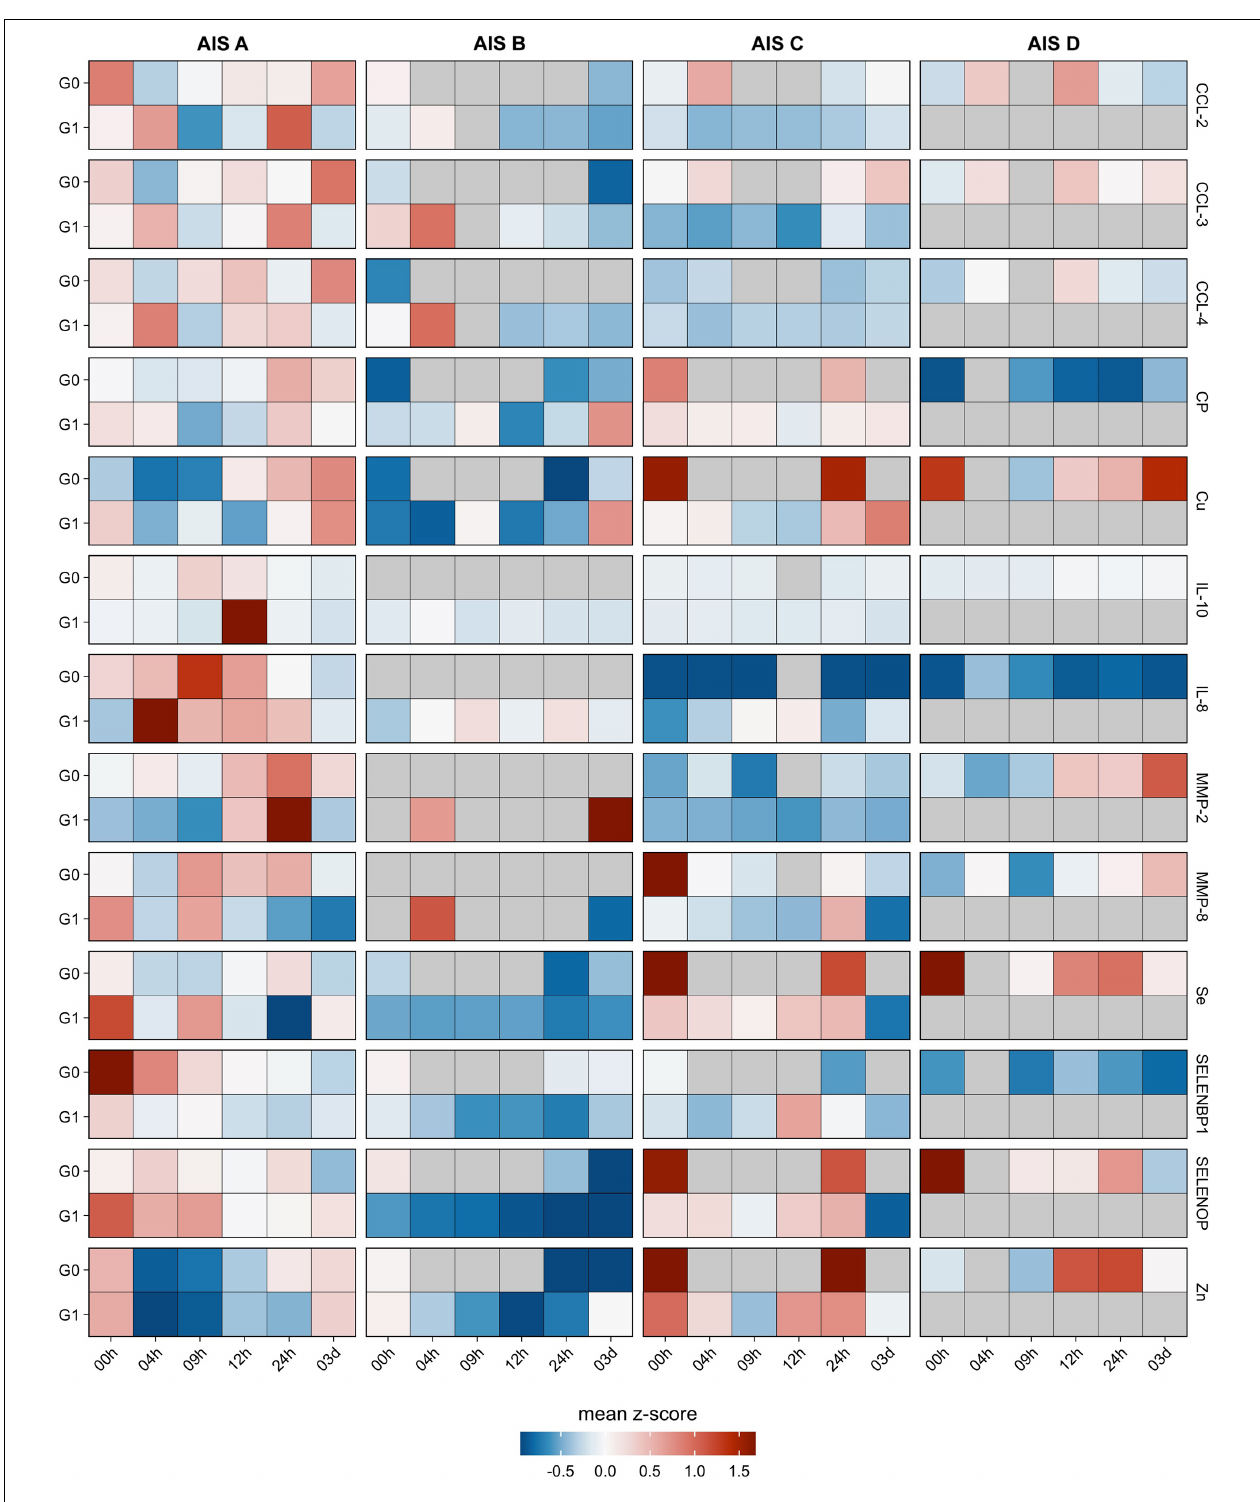
FIGURE 3 | Comparison of cytokines, metalloproteases, trace elements and related biomarkers in relation to neurological remission. The cytokines CCL-2, CCL-3, CCL-4 along with the metalloproteases MMP-2 and MMP-8 were analyzed from the serum samples of patients with TSCI in relation to remission (G1) or no remission (G0). In addition, the trace elements Cu, Fe, Se, and Zn as well as the Se-binding proteins SELENBP1 and SELENOP along with the Cu transporter CP were quantified in parallel. The heat maps indicate the relative concentration differences of these serum parameters in the two groups of TSCI patients (G0 and G1) in relation to the control group C. In addition, relative concentration differences are depicted in regard to the clinical severity of the neurological deficit, classified as AIS A–D according to the American Spinal Injury Association (AISA) impairment scale (AIS). Mean z-scores are indicated as color code.